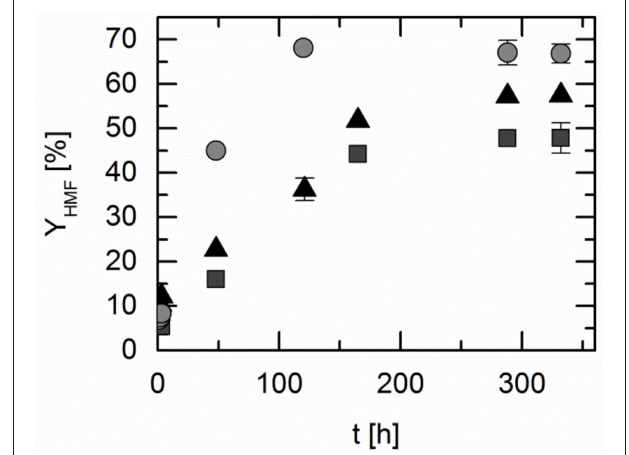
FIGURE 3 | The HMF yields (black bars) as well as the pH-values (gray bars) in the different deep eutectic solvents with molar ratio HBA:HBD 1:2. The HMF yields were achieved in the DESs consisting of the quaternary ammonium salts and levulinic acid or lactic acid. Data listed in Table S4 .